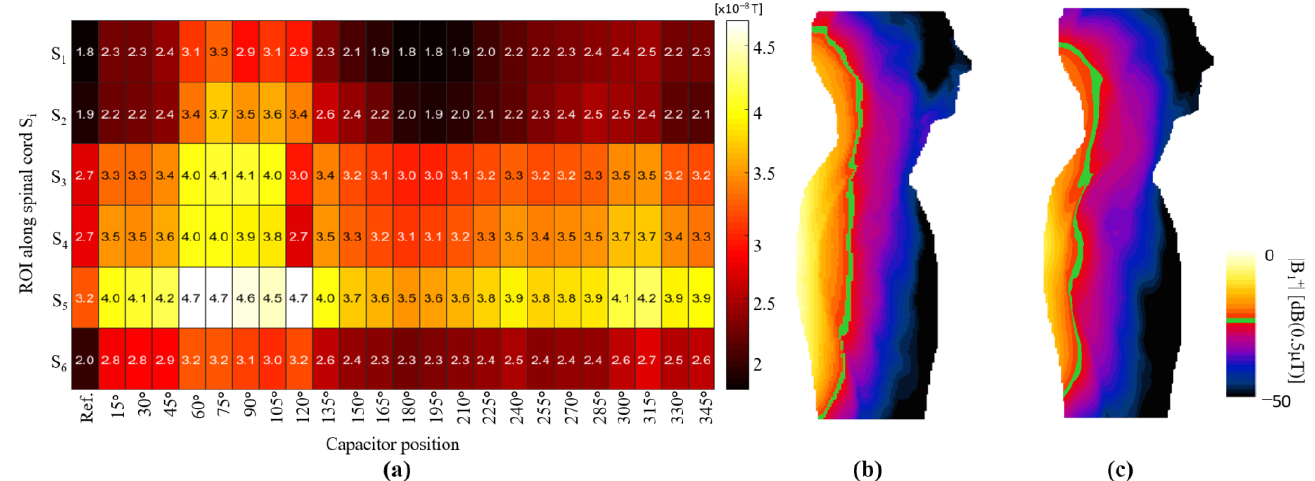
Figure 11. ( a ) Mean values of |B 1+ | field for all slices at coil center for all tested coil configurations. |B 1+ | field in ZY plane for ( b ) reference coil array, and ( c ) optimized coil array, showing highlighted magnetic field.